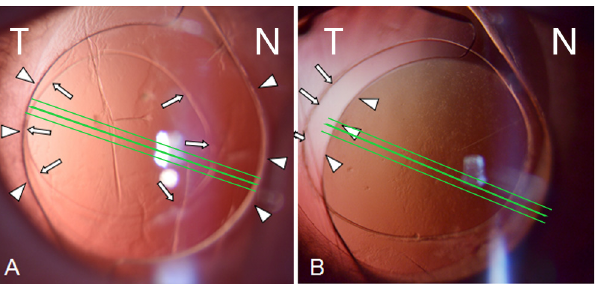
Fig 1. Schematic of relationship between anterior capsule (white arrow) and IOL optic edge (white triangle) in the scan position (green lines). N stand for nasal side, while T stand for temporal side. (A) The temporal side illustrates an undesirable overlap (the capsule overlap less on the IOL optic edge), and the right side illustrates a complete overlap (the capsule complete overlap the IOL in the scan position). (B) The temporal side capsule does not overlap the IOL optic.